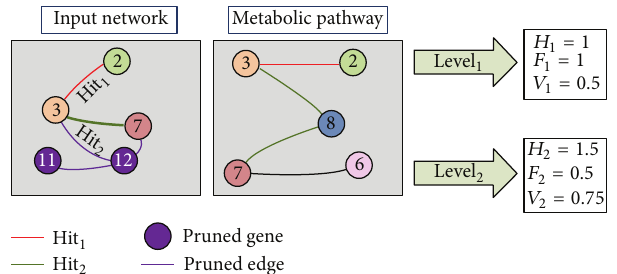
Figure 4: An example of the comparison using level 1 and level 2. Examples of Hit 1 and Hit 2 are presented. The purple nodes and their relationships are pruned for this specific evaluation because they do not belong to the metabolic